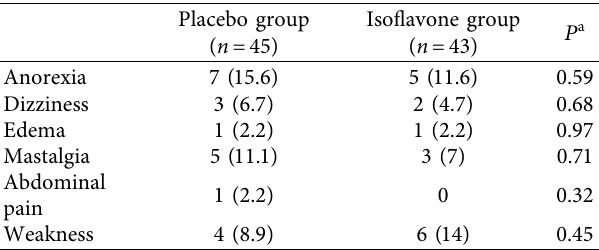
Table 3: Drug side efects in two intervention